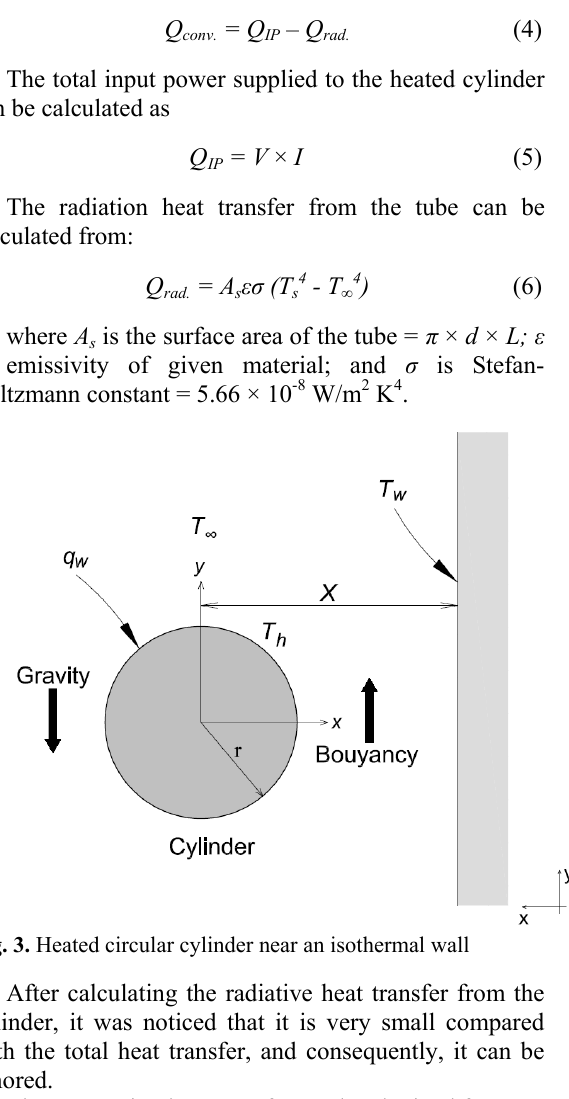
Fig. 9 shown for all tests that temperatures exhibit a larger change when the distance between the cylinder and the wall is less than 80 for all